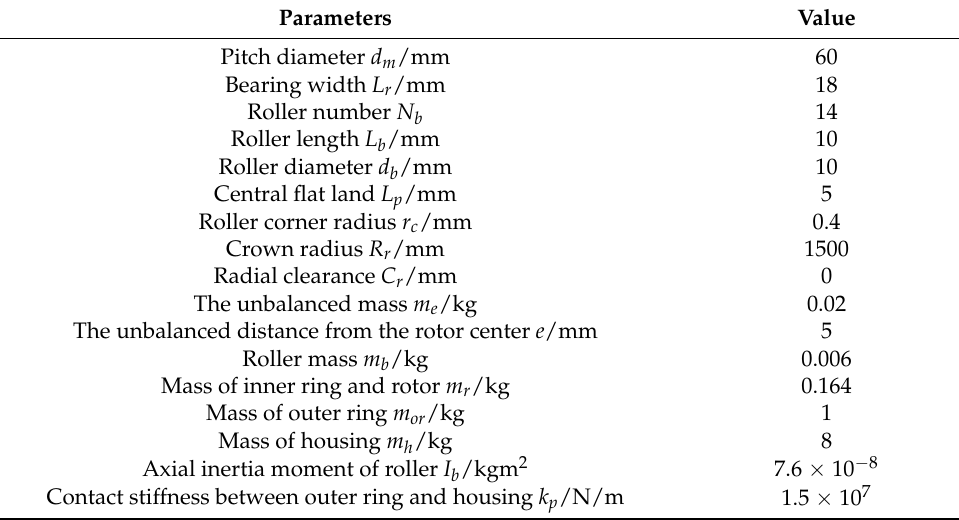
Table 1. Structure parameters for the simulated bearing.